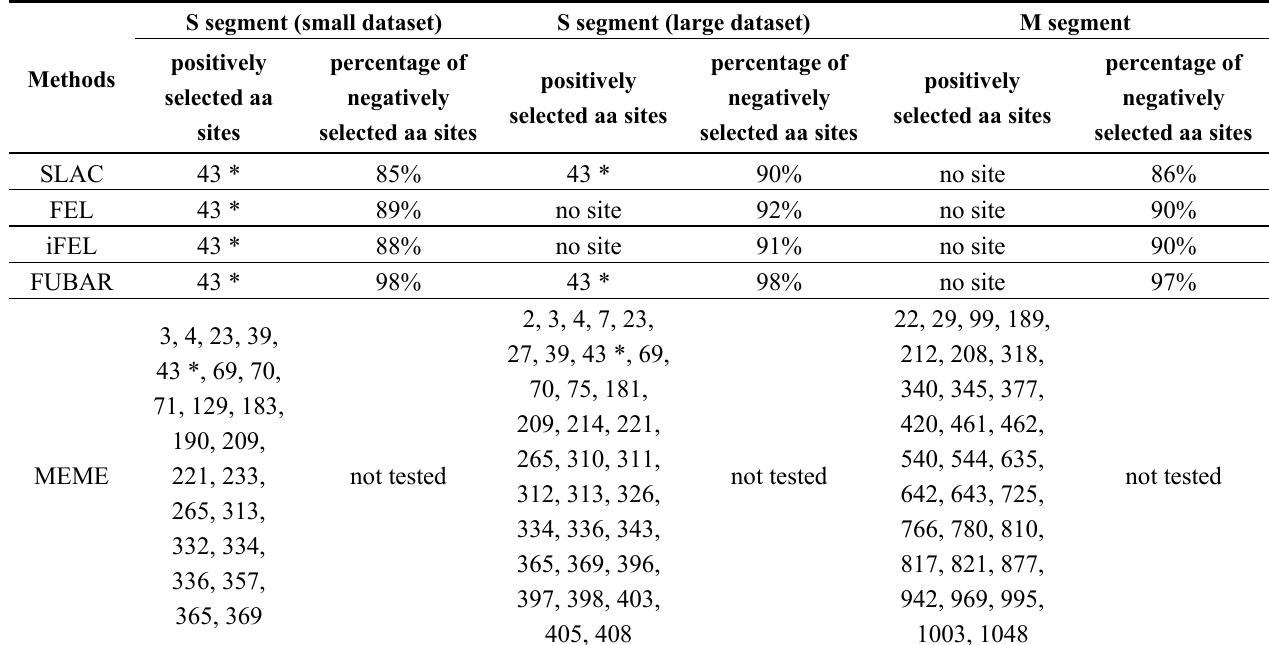
Table 1. Signatures of selection in S and M segments detected by SLAC, FEL, iFEL, FUBAR and MEME methods. * indicate sites identified as being under positive selection by at least two